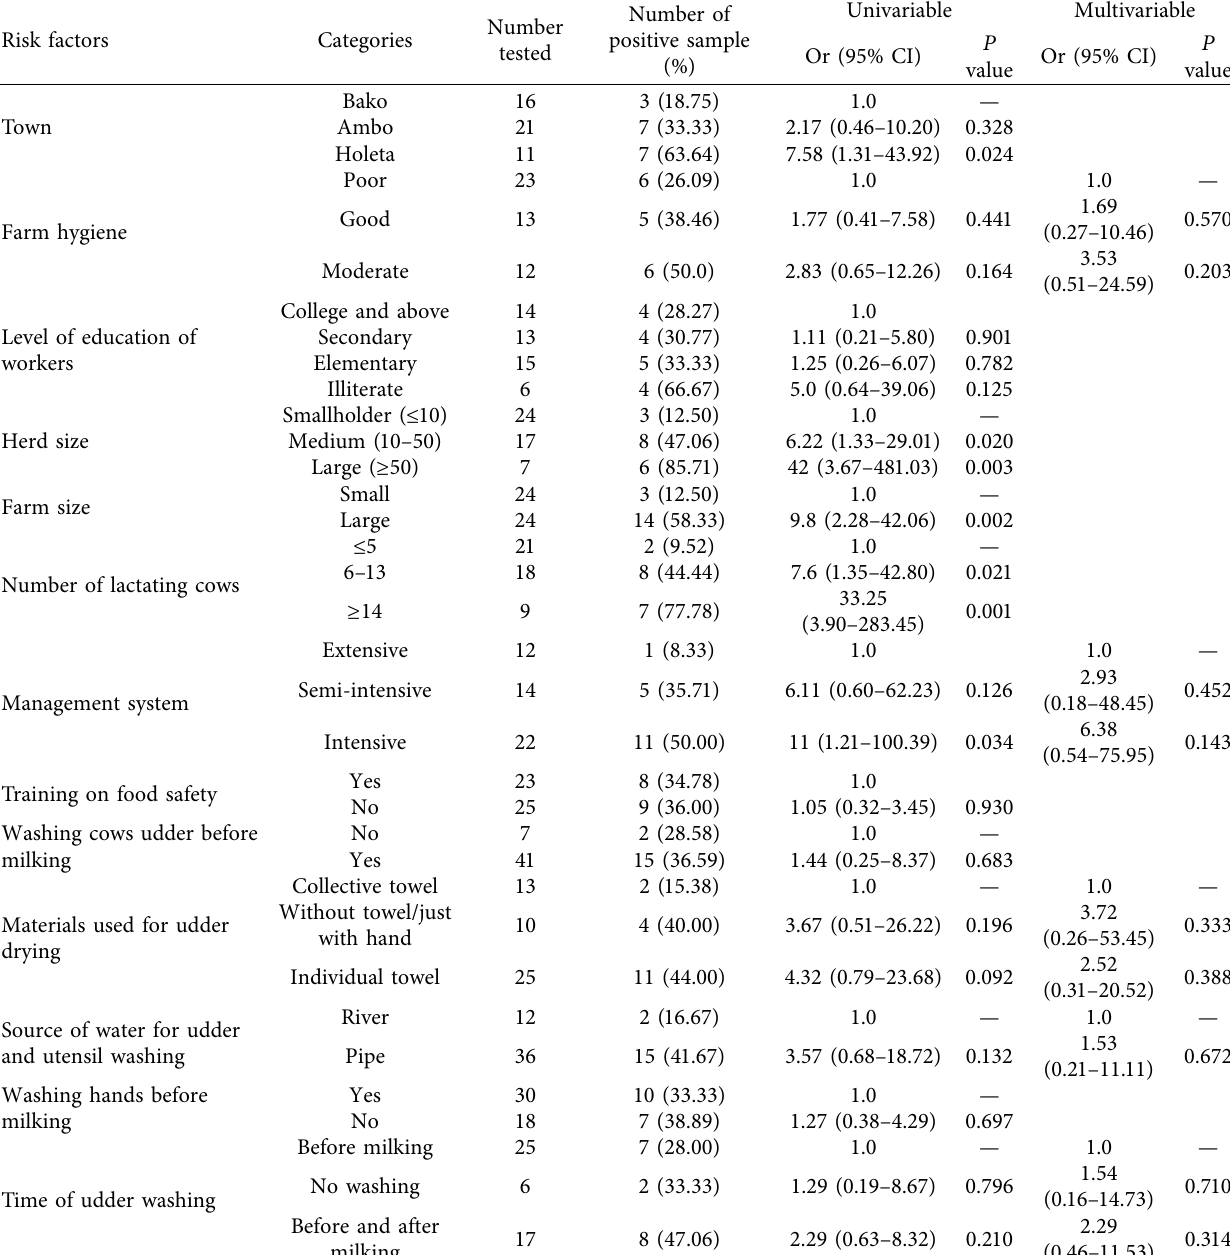
Table 3: Results of logistic regression analysis of farm-level potential risk factors for isolation of Listeria